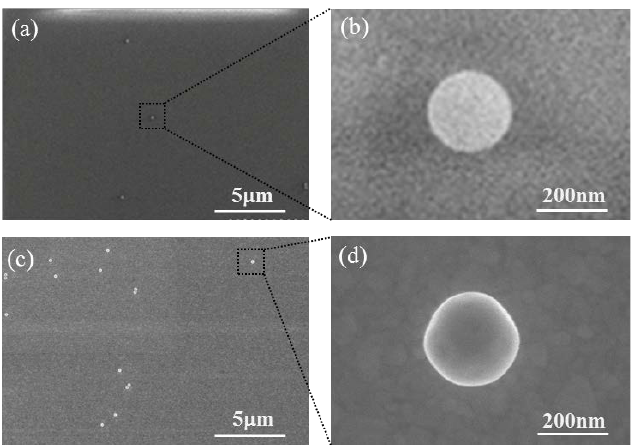
Figure 1. SEM imaging of ( a ) dispersed 200 nm PS nanospheres, ( b ) a single 200 nm PS nanosphere, ( c ) dispersed 200 nm Au nanospheres, and ( d ) a single 200 nm Au nanosphere.